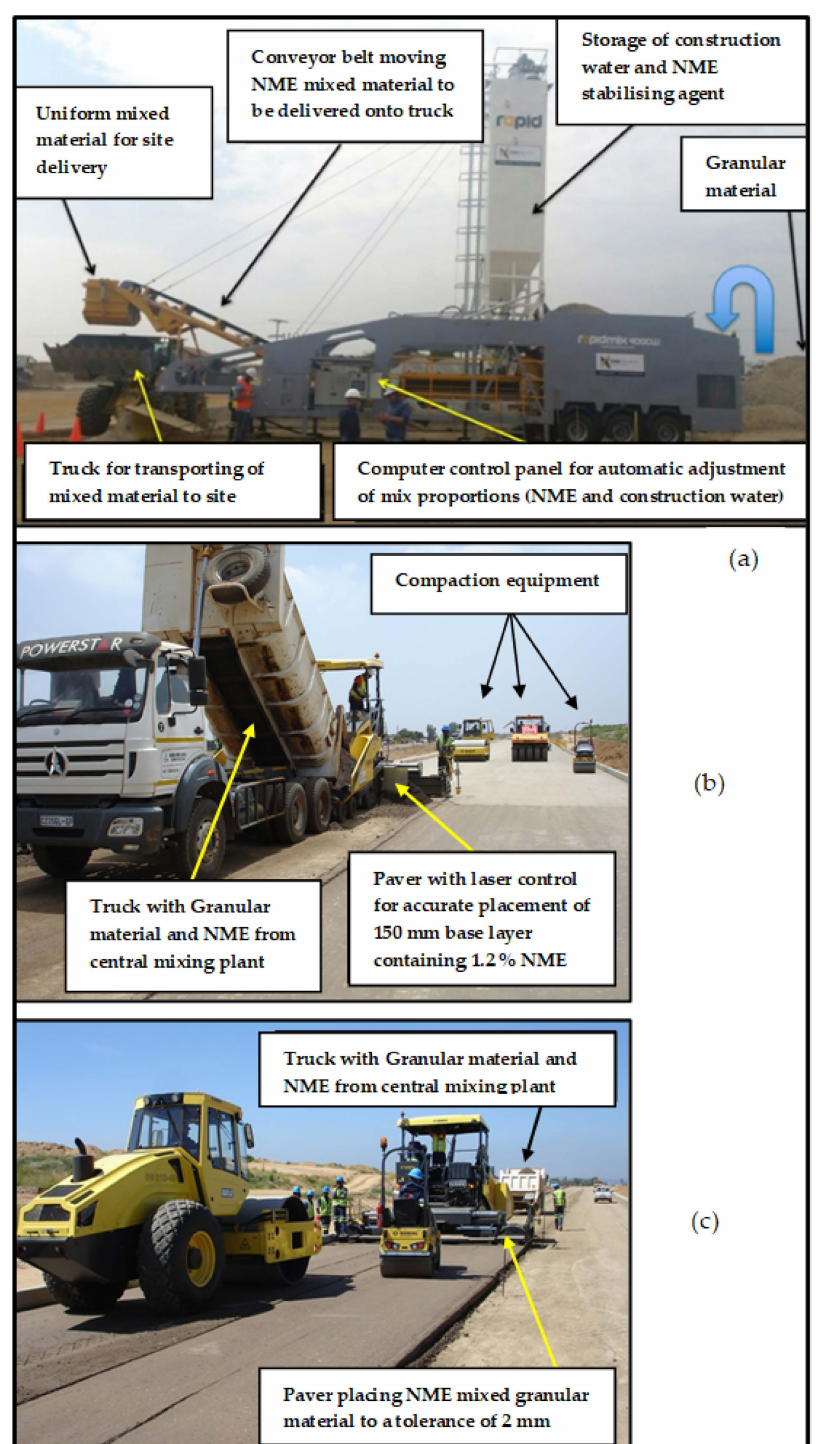
Figure 7. ( a ) Central mixing plant mixing the granular material with the required construction water containing the anionic NME stabilising agent for transportation to site; ( b ) delivering material in paver; and ( c ) compaction of